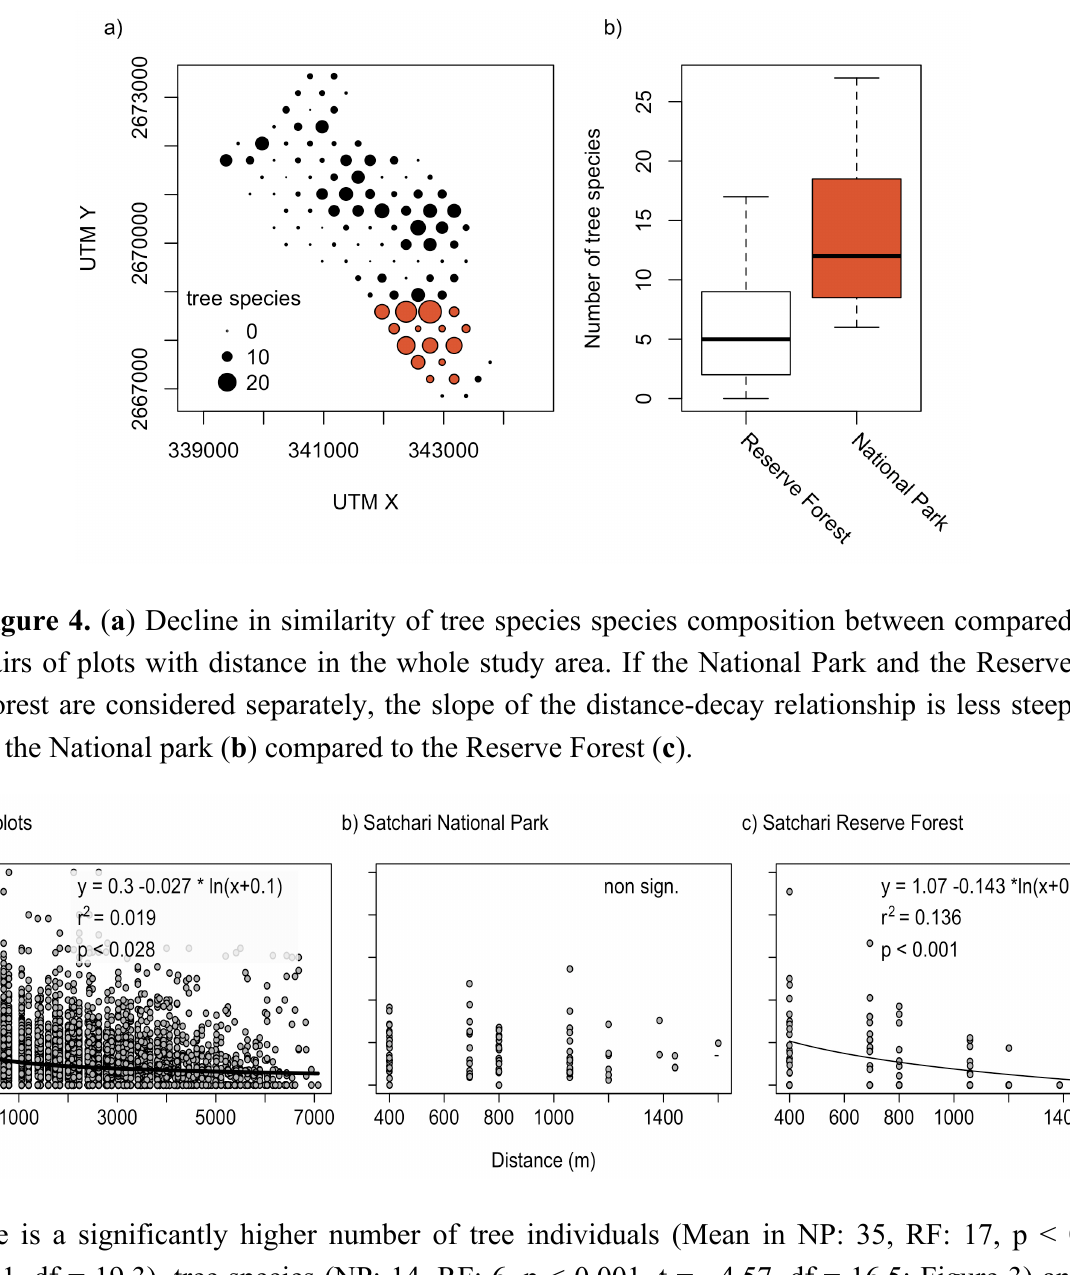
Figure 3. Tree species diversity in National Park and Reserved Forest (a) Spatial pattern of tree species richness in Satchari National Park (red) and Satchari Reserve Forest (black); (b) Influence of protection status on tree Alpha diversity is documented by significantly higher values in the National Park.